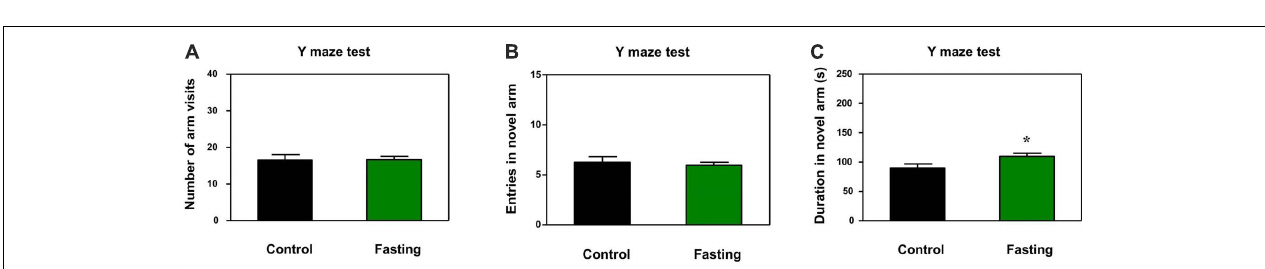
FIGURE 3 | Acute fasting enhances the natural behavior of mice in the open field test. The bar graphs show the total distance moved (A) , the latency to the center (B) , time spent in the center of the open field (C) , and freezing time (D) of mice in control (black columns) and fasting groups (green columns). Note that 9-h fasting significantly elevated the distance traveled and reduced the freezing time as compared to the control condition. Data are shown as means ± SEM (Mann-Whitney test or Student’s t -test; ∗∗ p < 0.01; n = 12–16 animals).